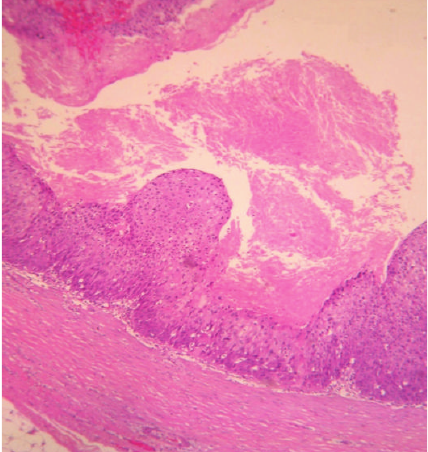
Figure 3: Cystic tumor portion where keratin amorphous deposits are observed (H and E, × 10).